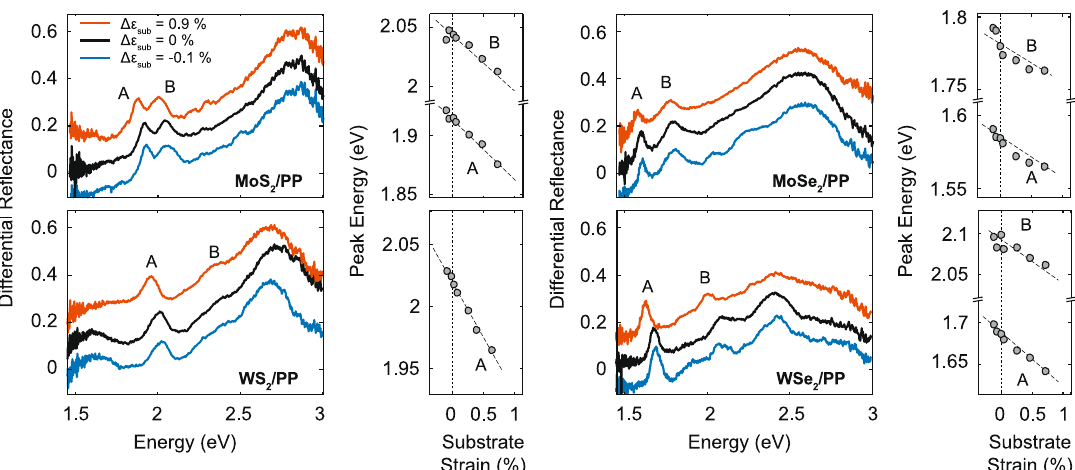
Fig. 4 Differential re fl ectance spectra of single-layer fl akes of the four TMDCs deposited on PP. The spectra have been measured as a function of the substrate expansion ( red curves ) and contraction ( black curves ) and are vertically shifted for clarity. Energy of the excitonic peaks (labelled A and B) as a function of substrate strain extracted from the differential re fl ectance spectra